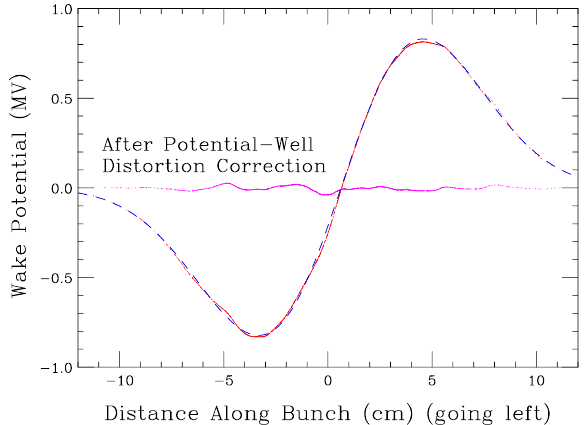
FIG. 3. (Color) Wake potential seen by the simulated bunch is shown by the red curve, which differs slightly from the wake potential of an ideal smooth Gaussian bunch shown in blue dashes. The difference shown by the magenta solid curve represents the random fluctuation of the finite number of